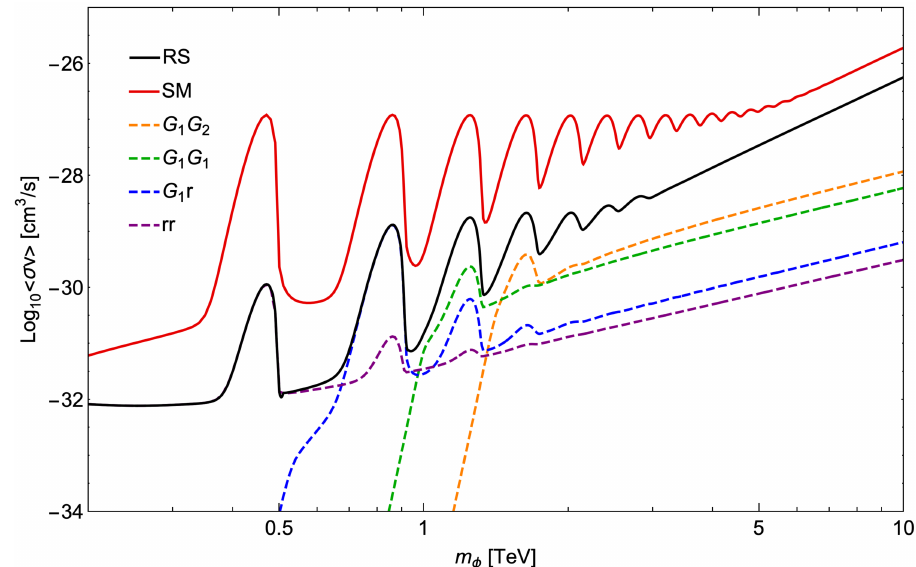
Figure 6 . Thermally averaged cross section into SM particles (red) and RS particles (black) final states for a representative set of parameters ( Λ = 20 TeV, m 1 = 1 TeV and m r = 100 GeV). The dashed lines correspond to the production of radion-radion (purple), G 1 -radion (blue), G 1 G 1 (green) and G 1 G 2 (orange). The contribution from heavier gravitons is not shown separately but included in the black line. The temperature is taken to be T = m φ / 20 as in figure